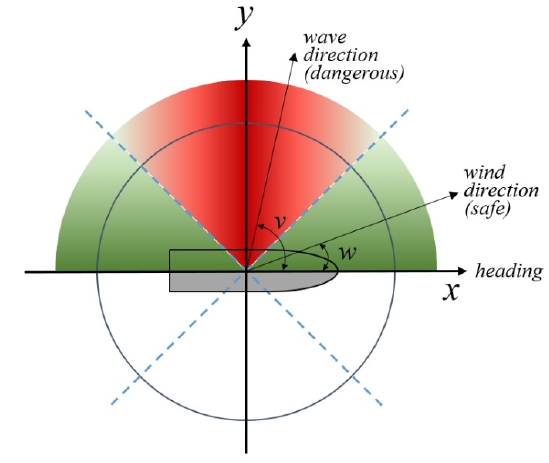
Figure 2. Ship navigation risk diagram.